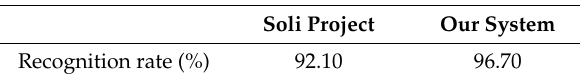
Table 5. Recognition rate comparison.